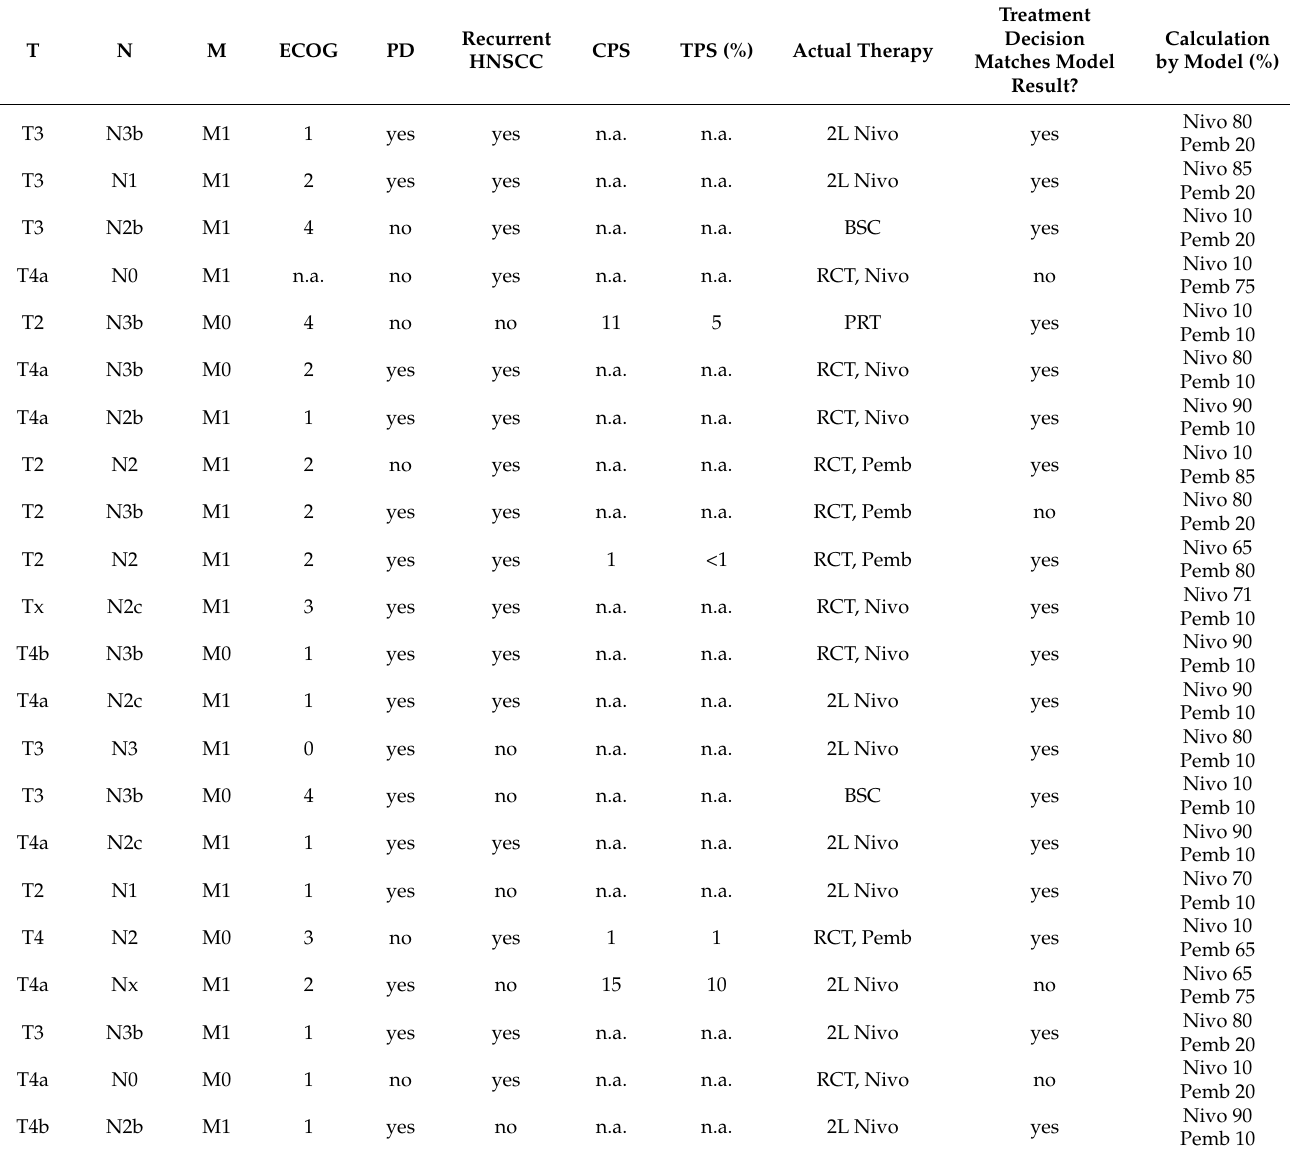
Table 1. Proposed treatments according to the Bayesian network immunotherapy submodel for 25 HNSCC patients referred to the tumor board for “R/M HNSCC patients and immunotherapy